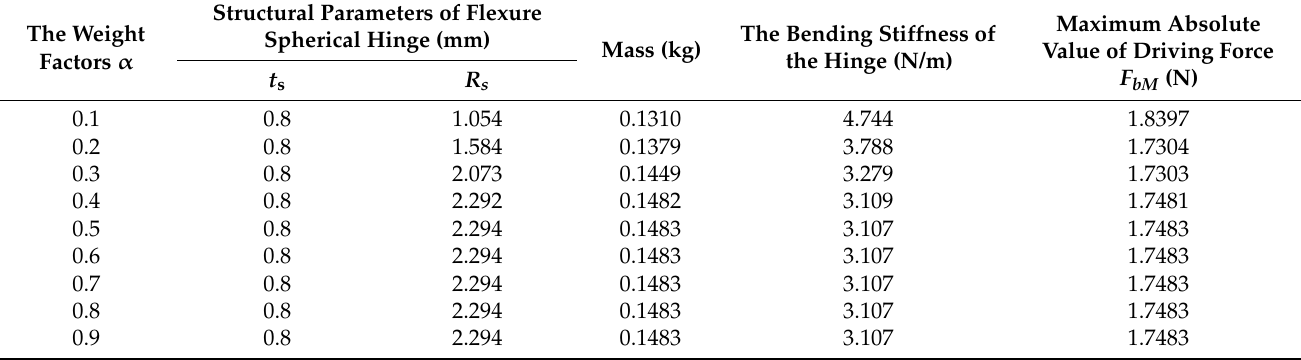
Table 2. Optimization results with the weight factors varying from 0.1 to